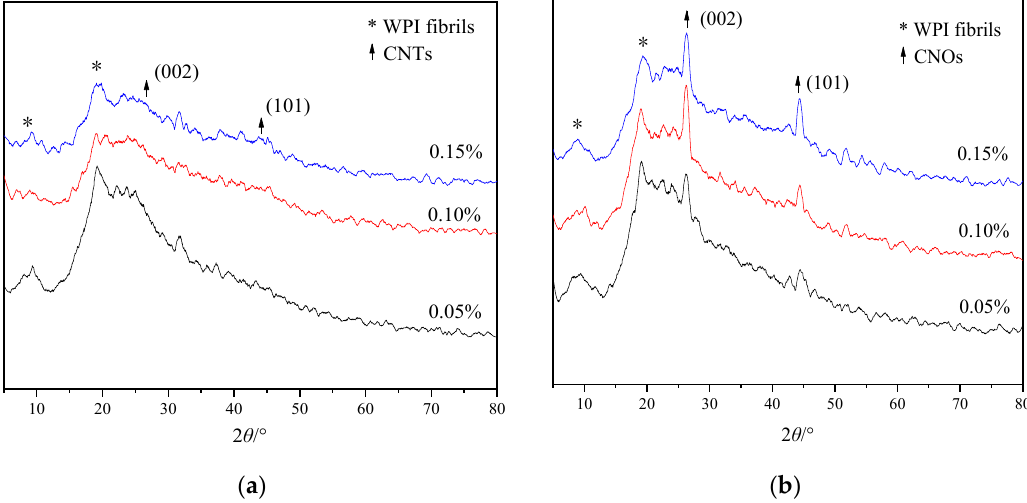
Figure 6. XRD patterns of WPI fibril–CNTs (or CNOs) (the concentrations of CNTs or CNOs were 0.05 wt.%, 0.1 wt.%, and 0.15 wt.%): ( a ) WPI fibril–CNTs; ( b ) WPI